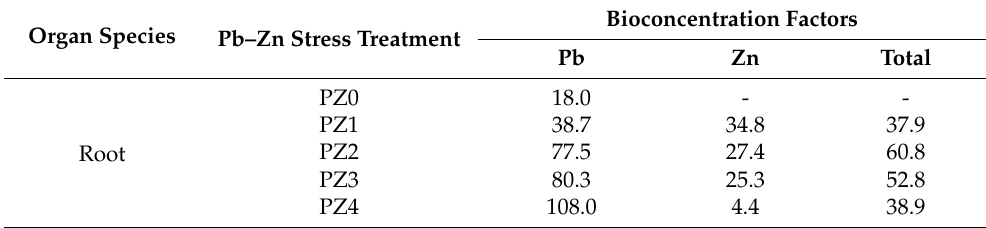
Table 2. Impacts of various Pb–Zn treatments on bioconcentration factors in four organs for 20 days. PZ0, PZ1, PZ2, PZ3 and PZ4 indicate that the Pb concentration is 300 mg/L and that the Zn concentrations are 0, 75, 150, 300 and 600 mg/L, respectively.